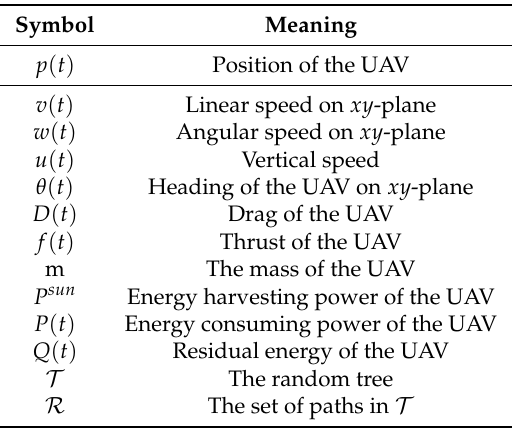
Table 1. Symbols and